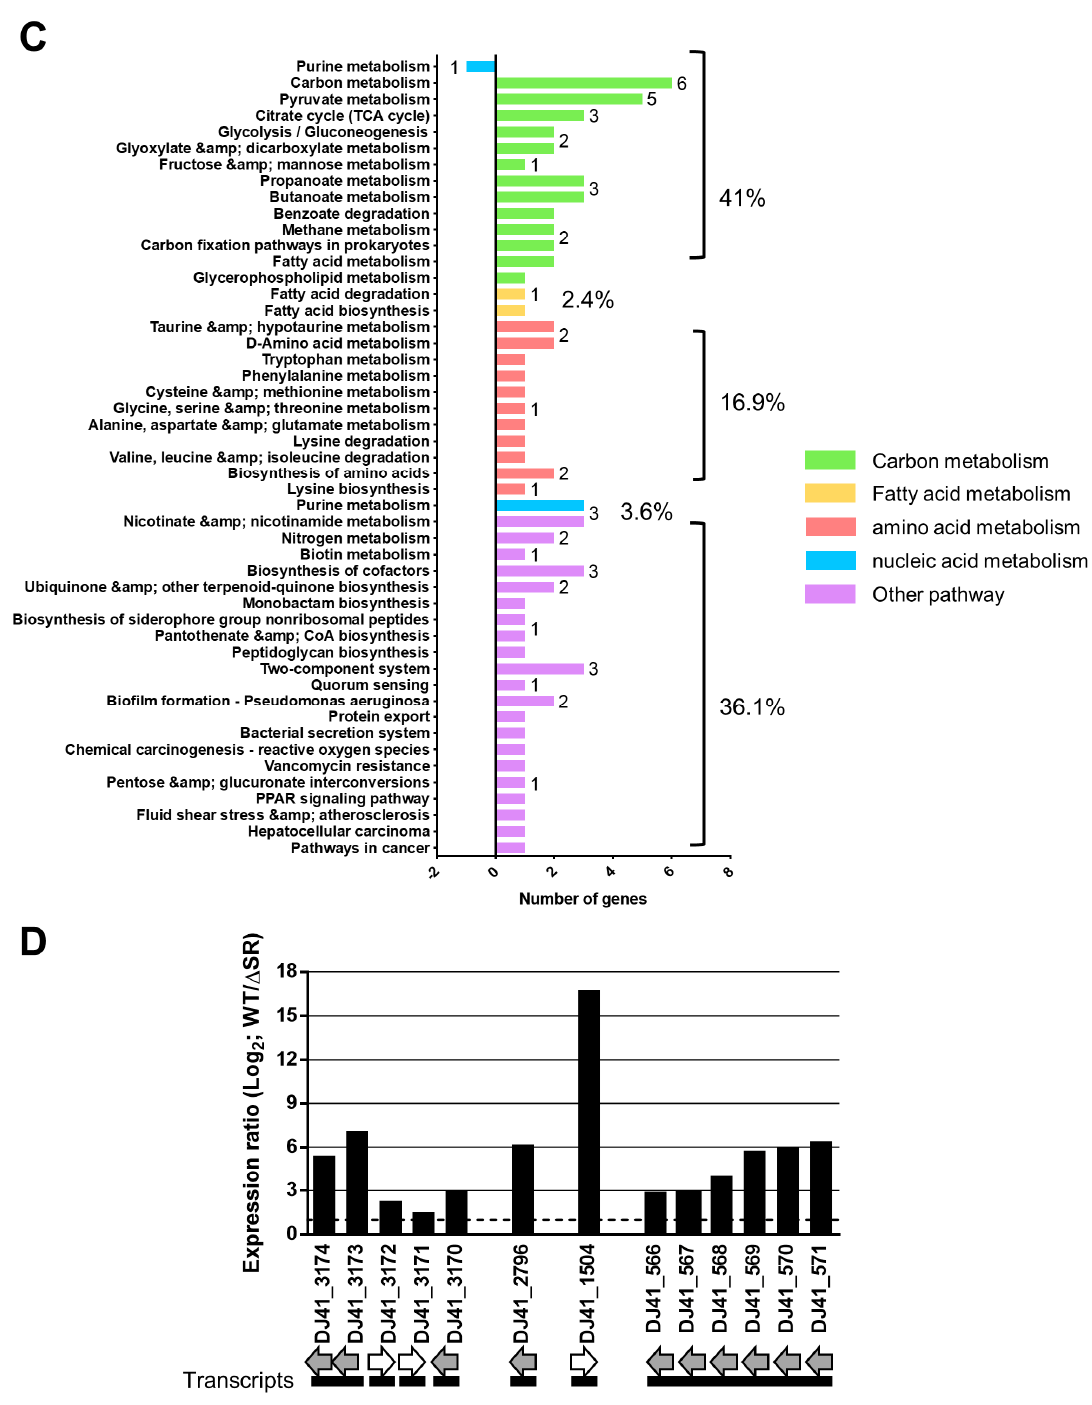
Figure 5. Transcriptome analysis of differential gene expression between A. baumannii wild-type and the emaSR , emaR , or emaS mutant strains. ( A ) Total number of upregulated genes for the emaS , emaR , and emaSR mutant strains in comparison with wild-type. ( B ) Metabolic classification of differentially expressed genes activated by EmaSR. ( C ) Metabolic classification of differentially expressed genes regulated by EmaR. Only one gene involved in purine metabolism was repressed by EmaR (blue bar at top). ( D ) Gene expression ratios of two highly expressed gene clusters. Black lines indicate individual transcriptional units. The dashed line represents the average expression ratio for all gene clusters depicted in each panel for one representative